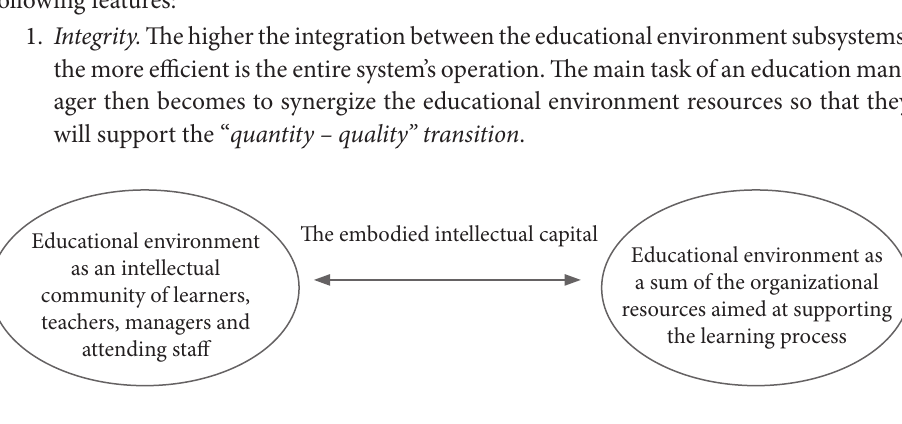
Fig. 1. Educational environment as a